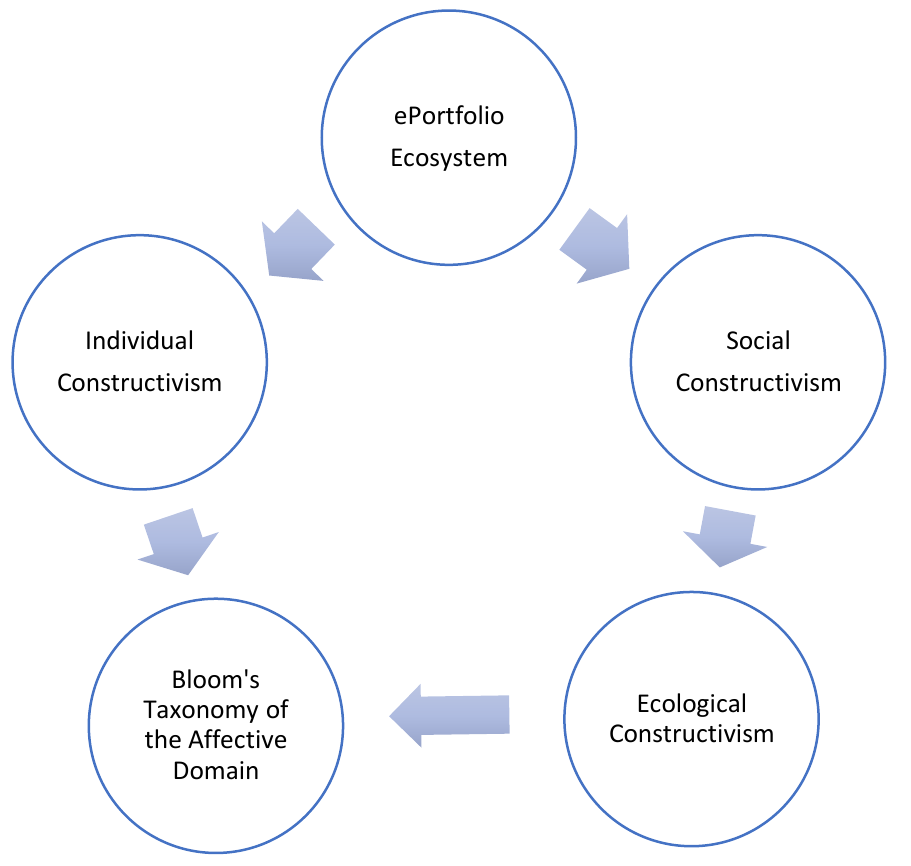
Figure 1: Eportfolio ecosystem and theoretical